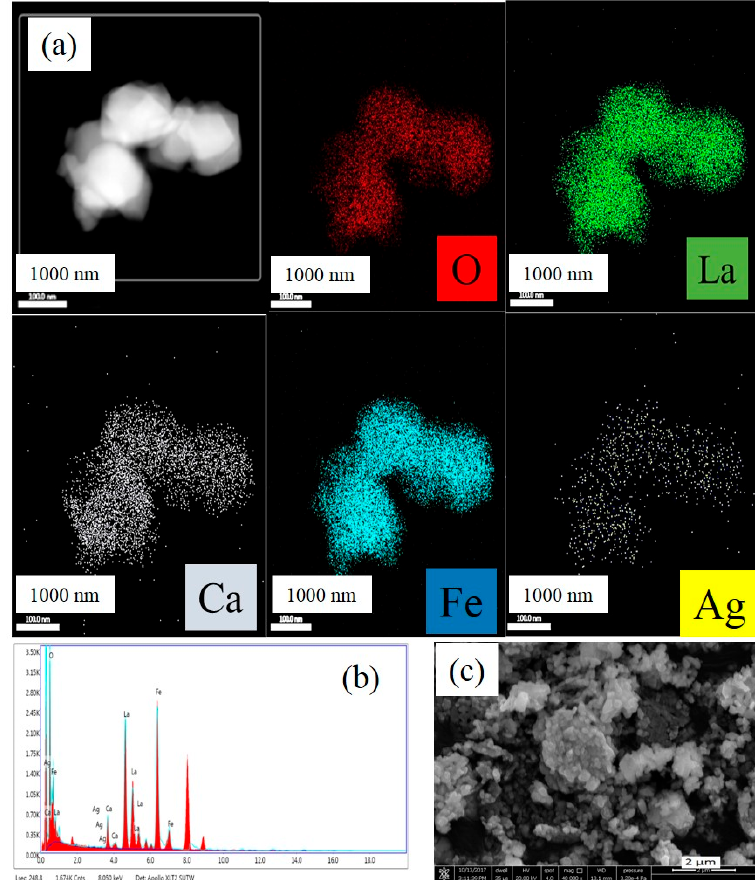
Figure 1. Typical TEM ( a ) and EDS elemental mapping and EDS spectra ( b ) and SEM image ( c ) of La 0.8 Ca 0.2 Fe 0.94 O 3 −δ + 0.05 Ag (LCFA) composite powder prepared by the EDTA–citric acid method (calcined at 900 °C).